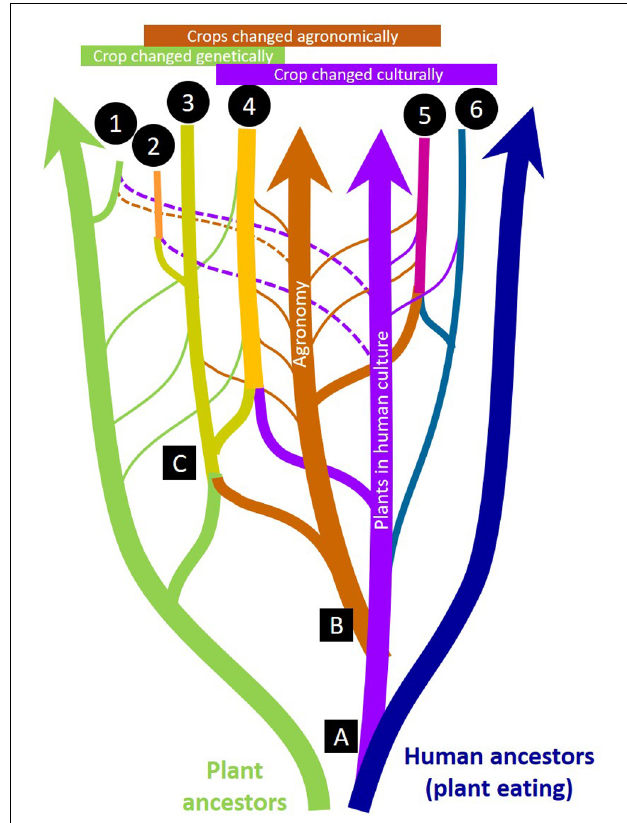
FIGURE 2 | Genetic, agronomic, and cultural changes are co-evolutionarily entangled in crop domestication. A reticulate biological/cultural “evolutionary tree” is shown in cartoon form (not to scale) to illustrate how “lineages” of plants, agronomic technology/traditions, and inherited human ethnobotanical culture “hybridize” to create different kinds of crops: (1) De novo incipient new crops from wild plants by breeding or gene editing (e.g., silphium), (2) New food crops developed from non-food crops by breeding or gene editing (e.g., intermediate wheatgrass), (3) Forage, fiber, and energy crops (e.g., alfalfa), (4) Major world food crops (e.g., maize, rice), (5) Cultivated crops with little genetic change (e.g., cranberry), (6) Culturally important wild-crafted food and medicinal plants (e.g., ‘akkoub). Major evolutionary innovations are numbered: (1) Cultural references to plants (names, stories, recipes, etc.) appear, (2) Agronomic practices appear, (3) Genetically distinct cultigens appear. Narrow lines show “horizontal” influences such as accidental or deliberate gene flow between cultigens and wild relatives (narrow green lines) or changing cultural uses of harvested plants (narrow purple lines) or the influence of new agronomic practices and technologies (narrow brown lines). Dotted narrow lines indicate a very recent or emerging influence.